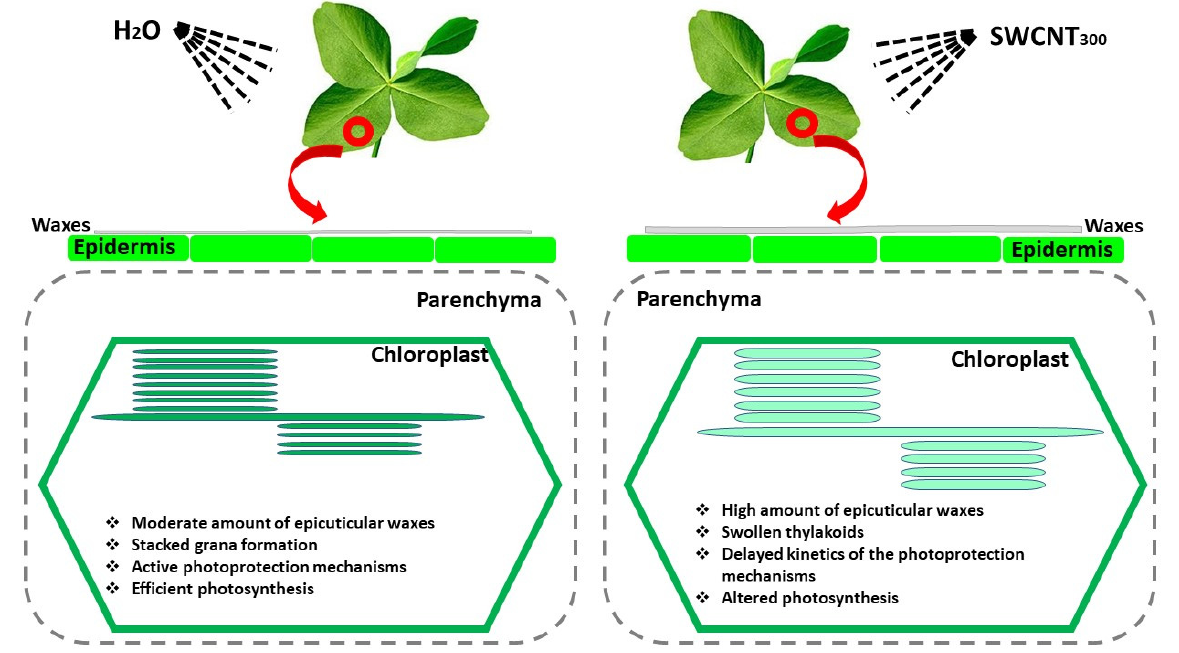
Figure 9. Foliar application of SWCNT 300 to intact pea leaves provokes accumulation of epicuticular waxes, induces thylakoid swelling and modifies the chloroplast ultrastructure, slows down photoprotection mechanisms and negatively affects photosynthesis. The observed functional, structural and morphological changes are concentration-dependent .